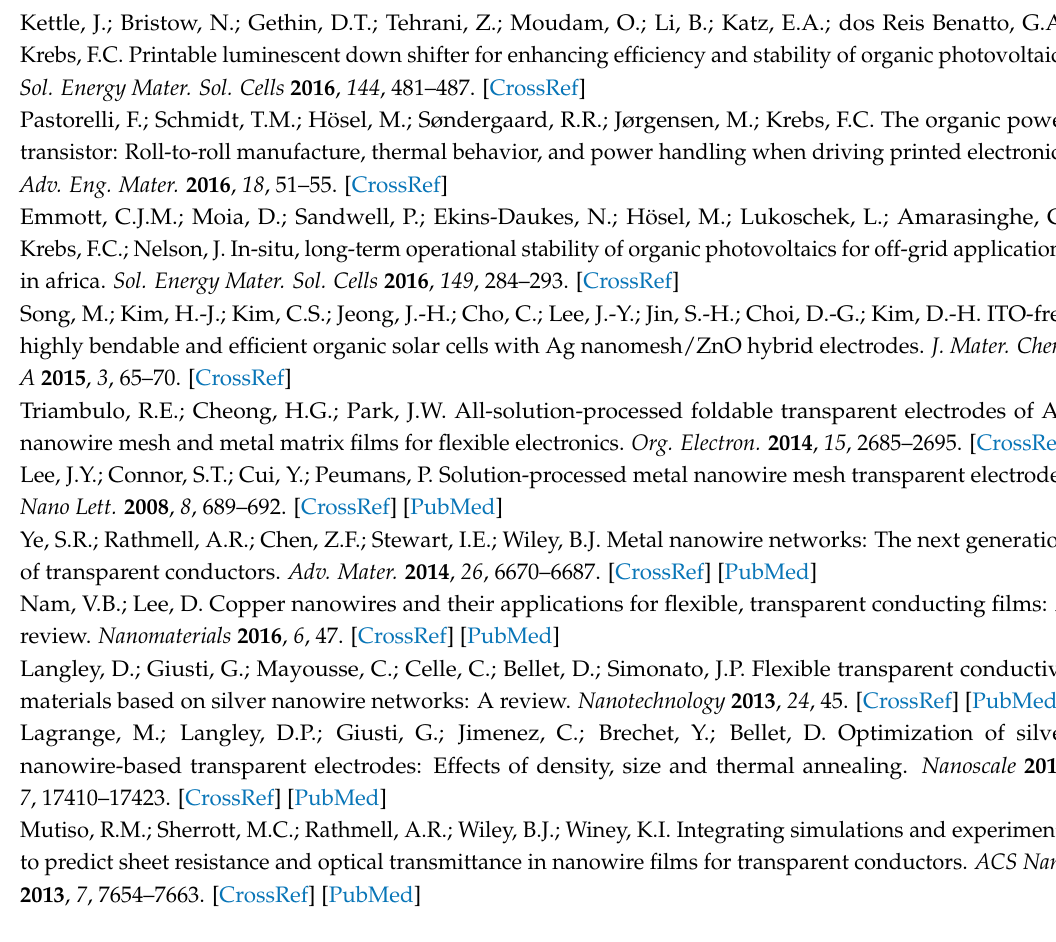
Figure S1: AFM topography images of (a) AgNW and (b) HP-AgNW films; Figure S2: R s of PET/AgNWs film at different hot-pressing times and temperatures; Figure S3: UV-Vis spectra of PET/AgNWs film treated at different HP temperatures for 10 min; Figure S4: SEM images at a 45 degree inclination: (a) PET/AgNWs/PEDOT:PSS before hot-pressing treatment; (b) PET/AgNWs/PEDOT:PSS after hot-pressing